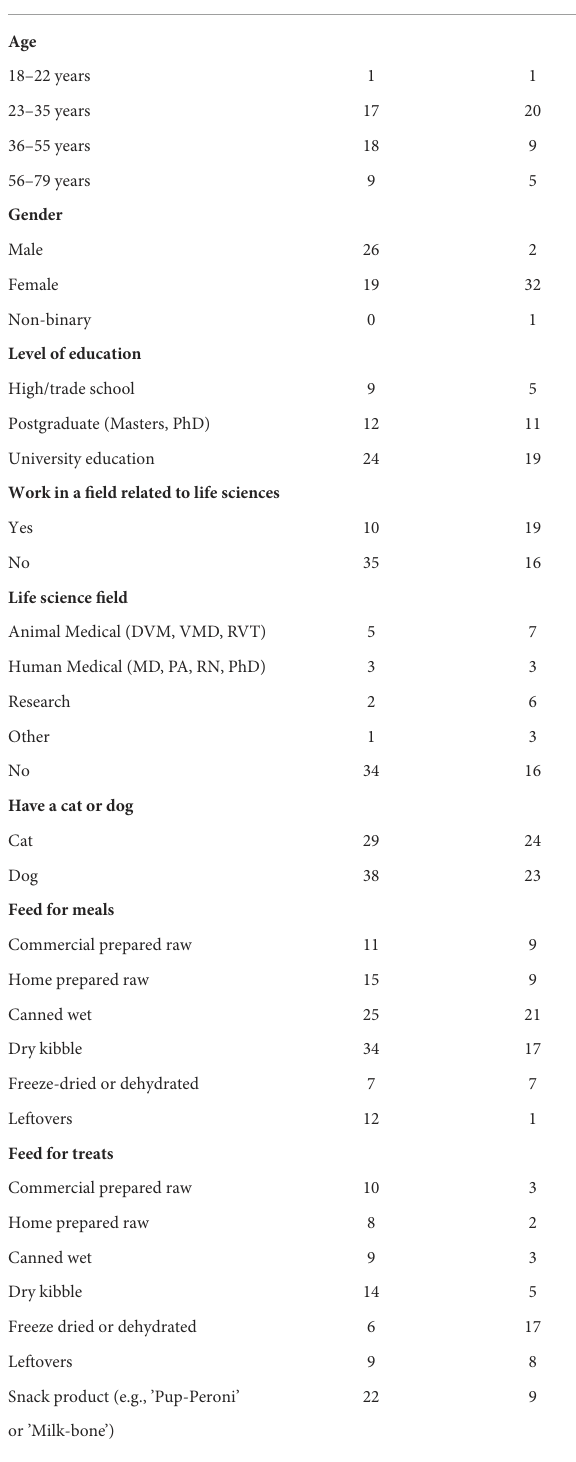
TABLE 1 Survey participant demographics were separated by each recruitment source of MTurk ( n = 45) or social media ( N =